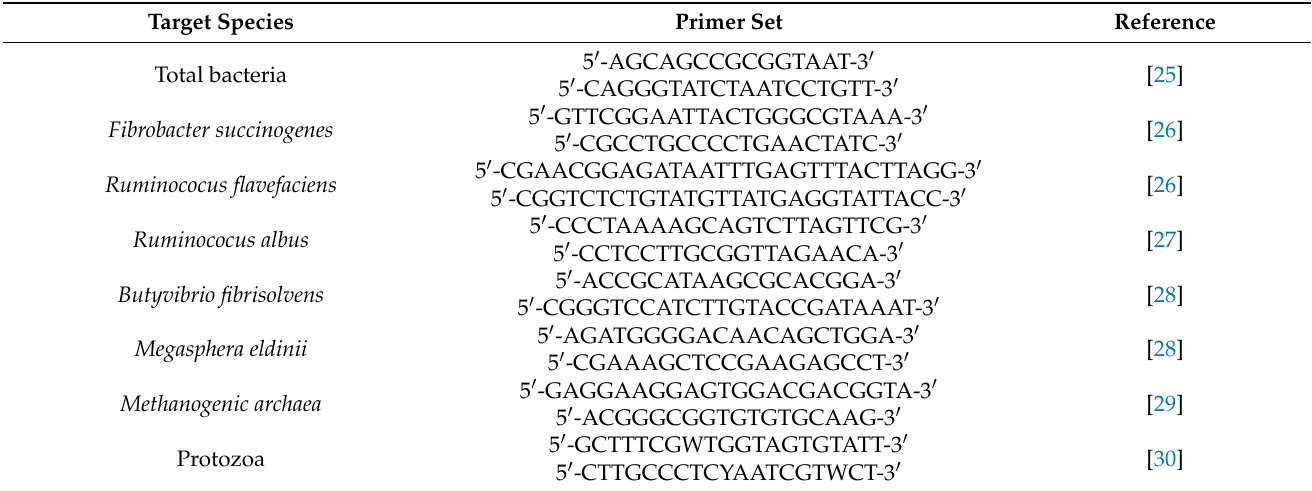
Table 2. PCR primers for real-time quantitative PCR